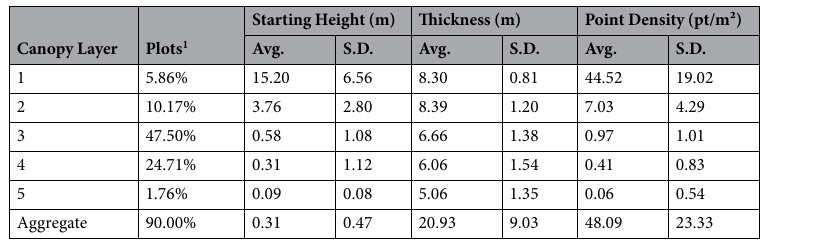
Table 1. Summary statistics of canopy layers over the 50,911 sample plots regularly distributed in Robinson Forest. 1 Plots having as many number of canopy